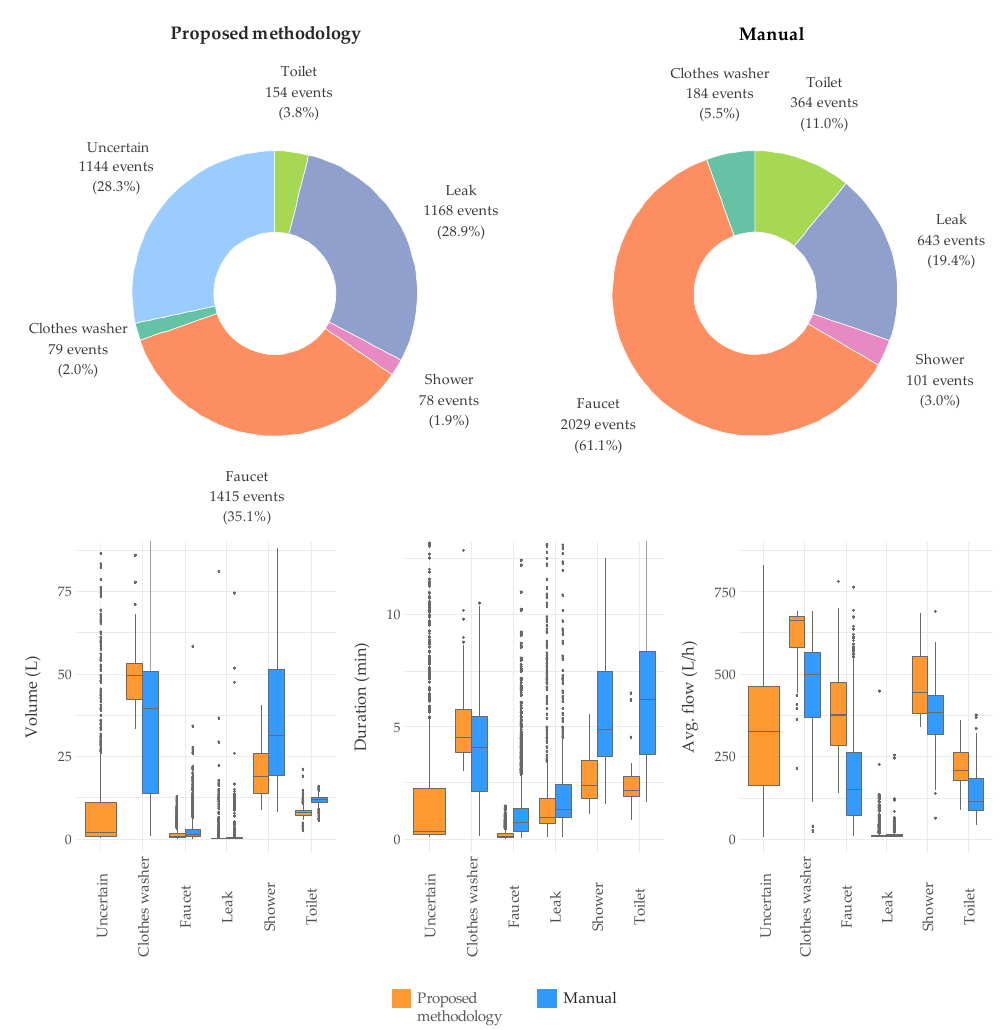
Figure 11. The manual vs proposed methodology final results of complete disaggregation processing for the household HH ‐ 06 of the R1 study.